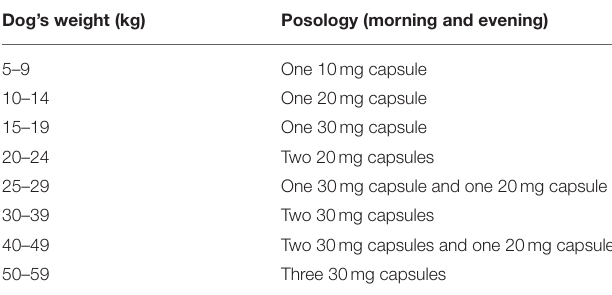
TABLE 1 | Posology of the cyproterone acetate in the study. Dog’s weight